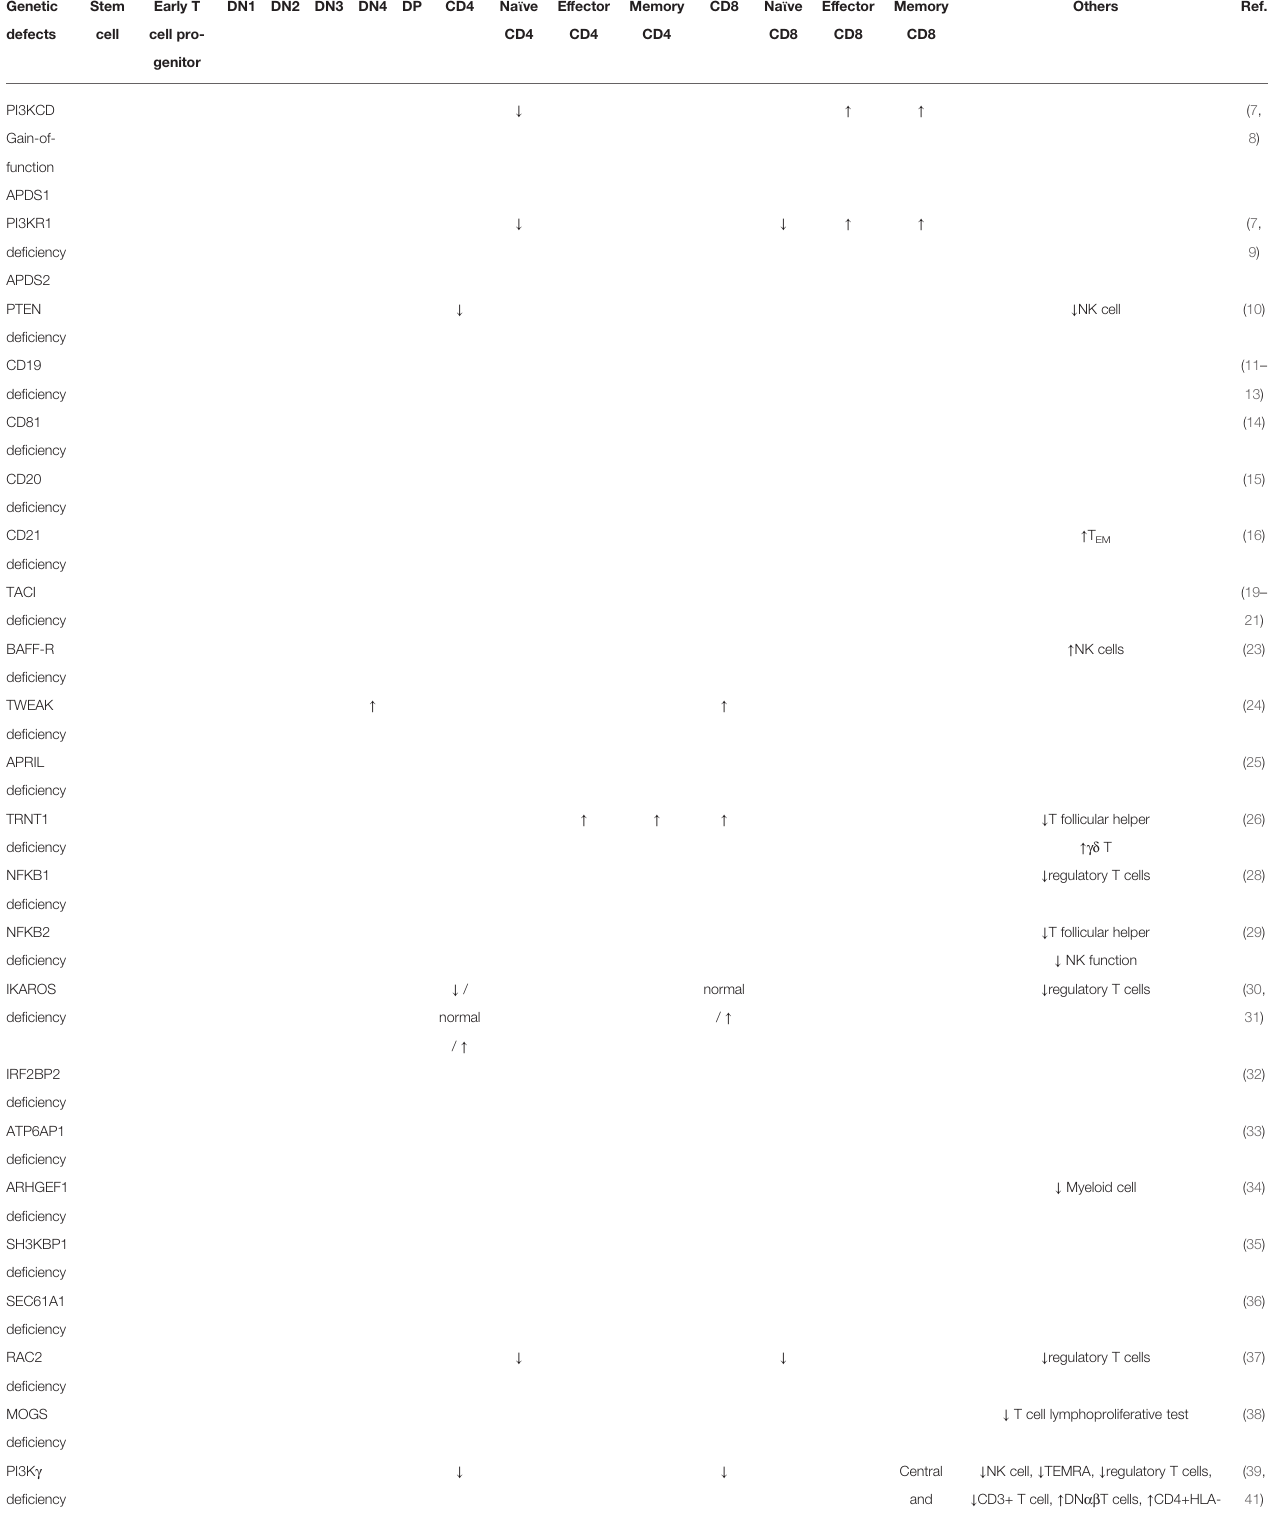
TABLE 2 | T-cell subset abnormalities in monogenic CVID. Genetic